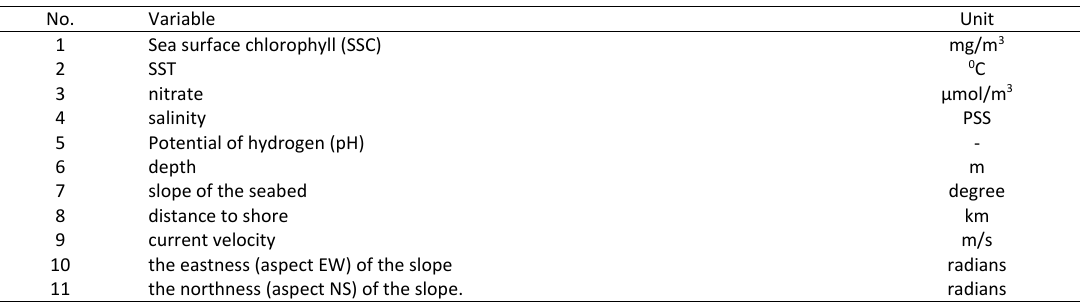
Table 1: Environmental variables used in the study